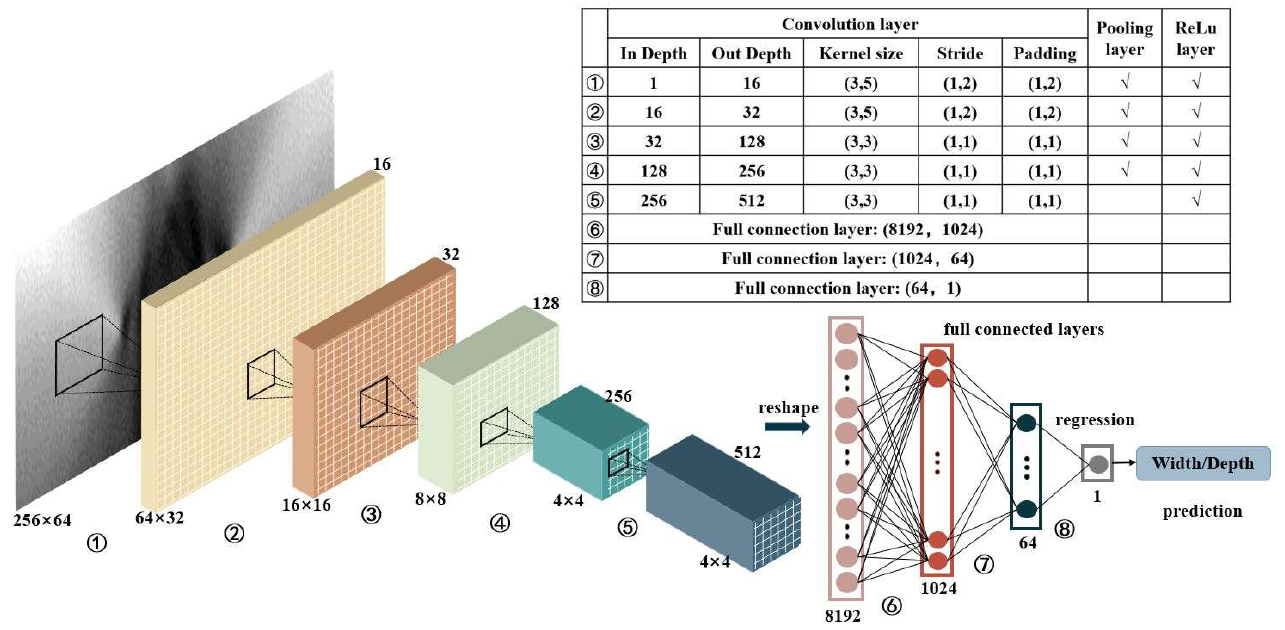
Figure 6. Schematic diagram of improved CNN model.